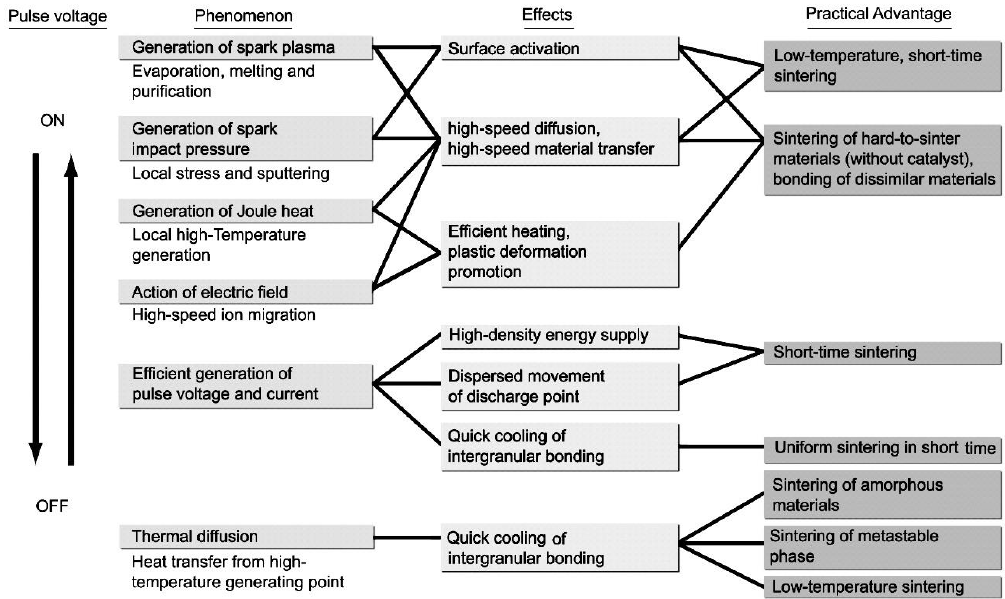
Figure 9. Effects of ON-OFF DC pulse energizing.